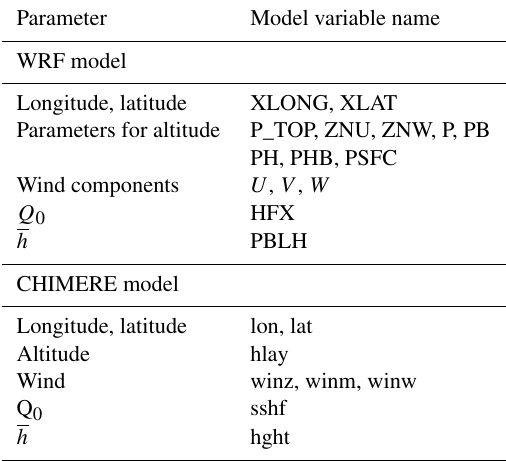
Table G1. List of parameters read by the Backplumes programme to calculate